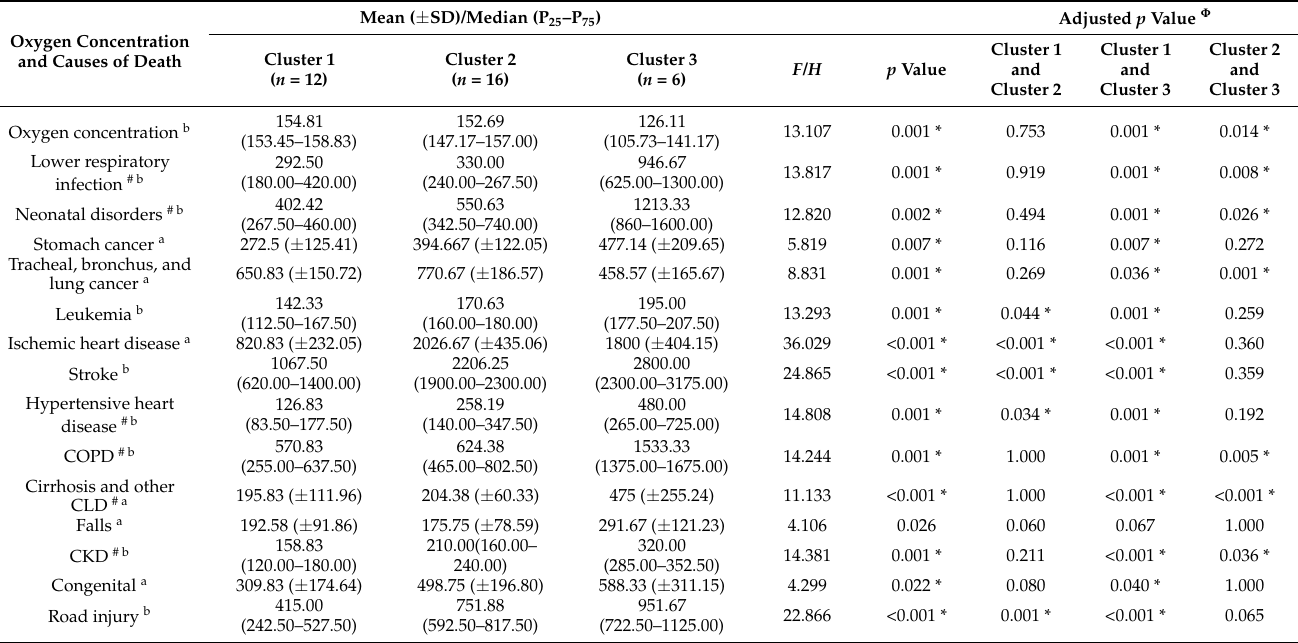
Table 3. Comparison of oxygen concentration and age-standardized years of life lost per 100,000 population for several causes of death between the clusters λ .